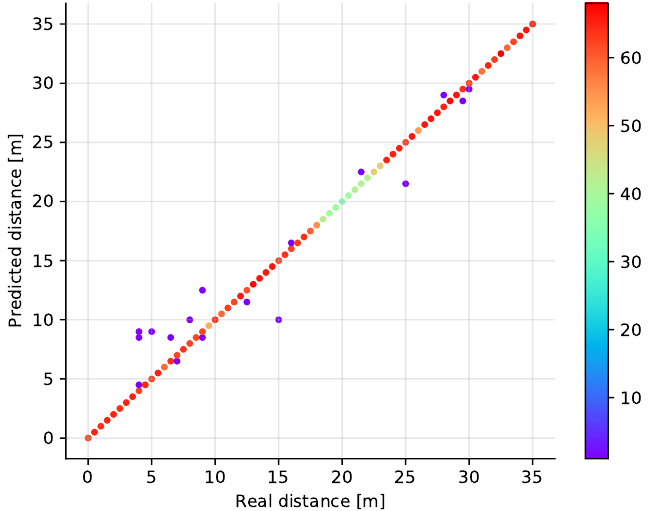
Figure 10. Scatter plot showing the predicted versus the real distances in a single dimension for the SVM classifier with C =